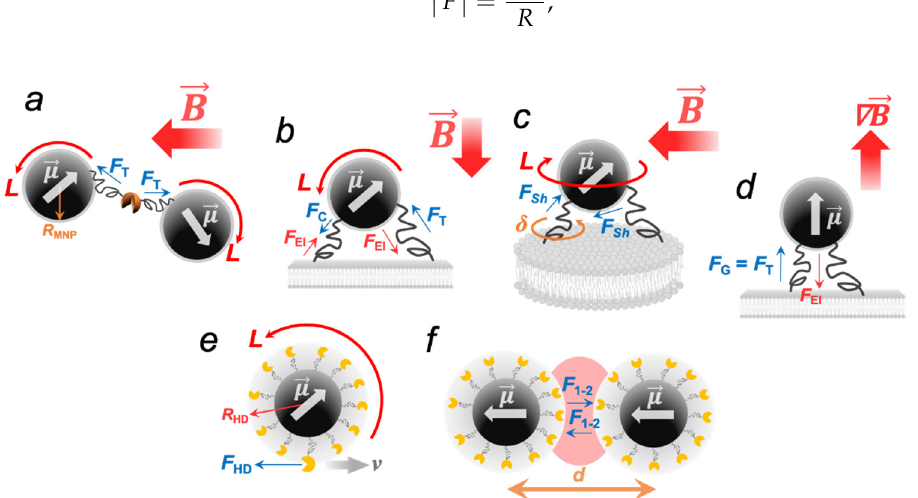
Figure 5. Forces and torsion stress exerted on macromolecules anchored to MNPs: ( a – c ) oscillat- ing/rotating MFs; ( d ) after exposure to SMFs with a filed gradient ∇ B ; ( e ) hydrodynamic force F HD acting on a macromolecule during the MNP rotational movements; ( f ) attractive force F 1–2 arising between two MNPs as a result of magnetic dipole interactions. F T , F C , F Sh are the contact forces of stretching, compression, and shear, respectively; F G is the pulling force generated by the filed gradi- ent (analog to F T ); δ is the torsional stress arising on the macromolecules. The elastic force F El tends to return a macromolecule to its natural shape.